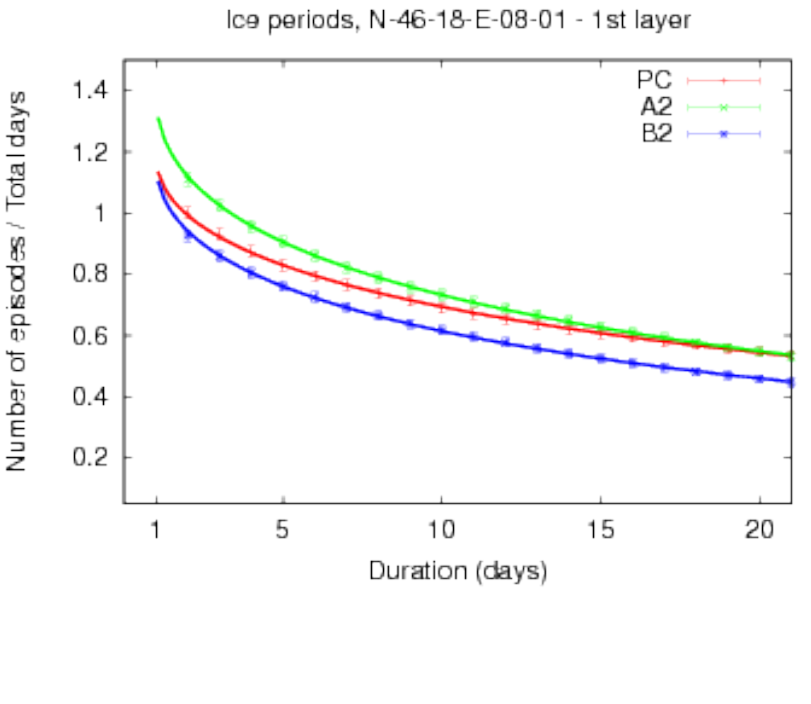
Figure 2. Frequency of cold spells versus their duration: the case in which the number of events increases in a future scenario.